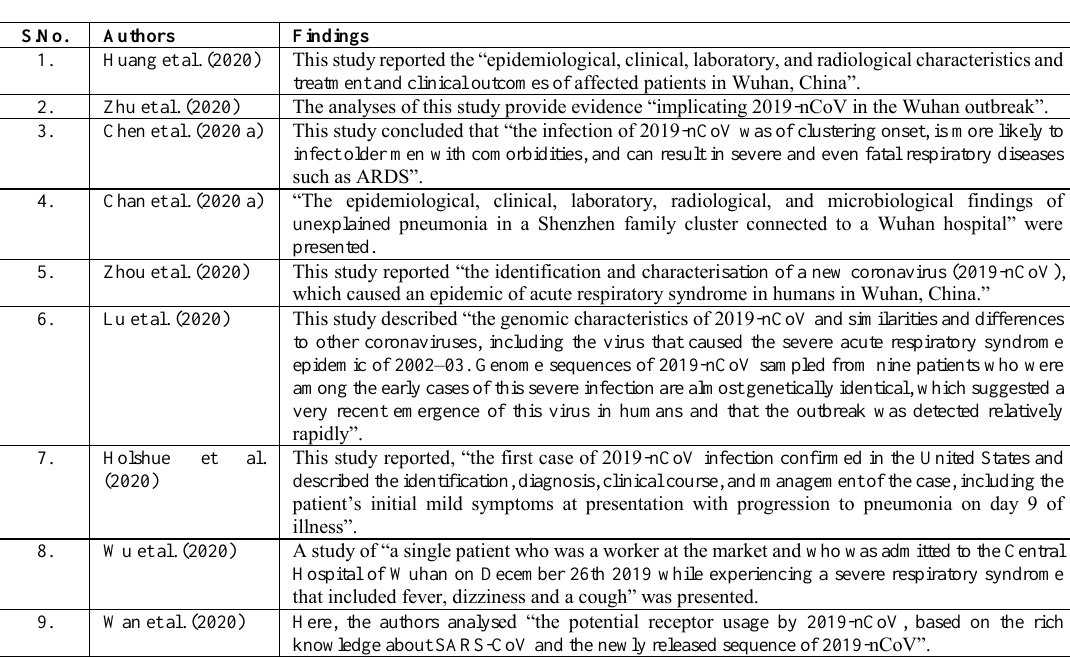
Figure 6. Comparison of total worldwide COVID-19 cases with India and China on every 10 th situation report of W.H.O. Table 2. High impact articles on